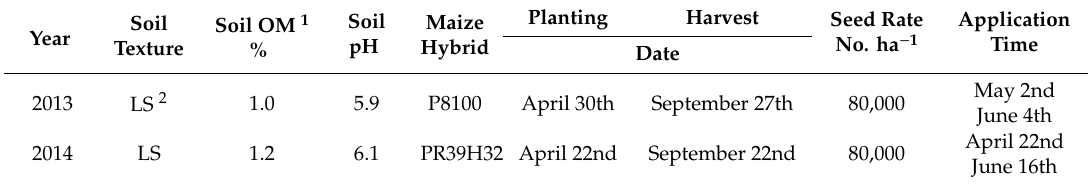
Table 1. Soil characteristics, maize hybrid, planting and harvest dates, seed rates, and application time for field studies carried out in Brody, PL in 2013 and